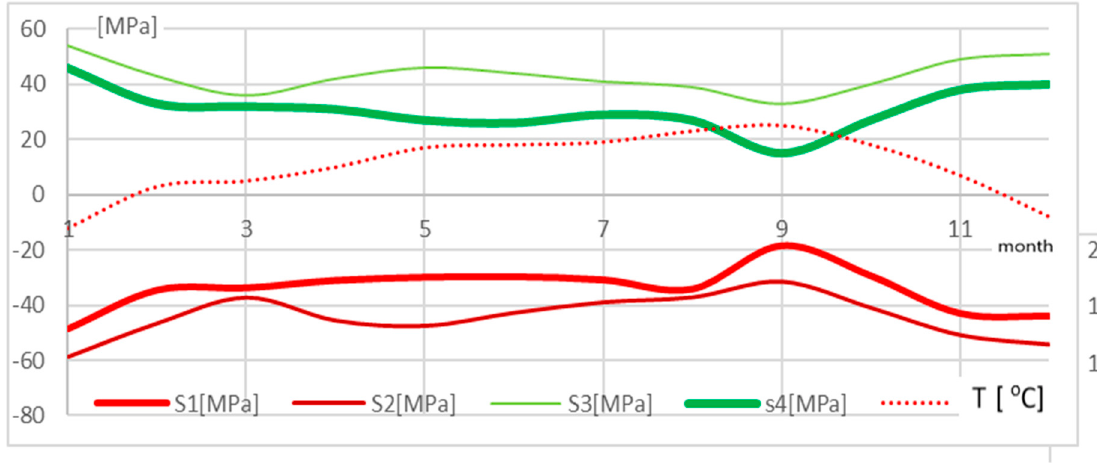
Figure 8. Stress and temperature distribution in the legs of tower A located on an island in a lake.